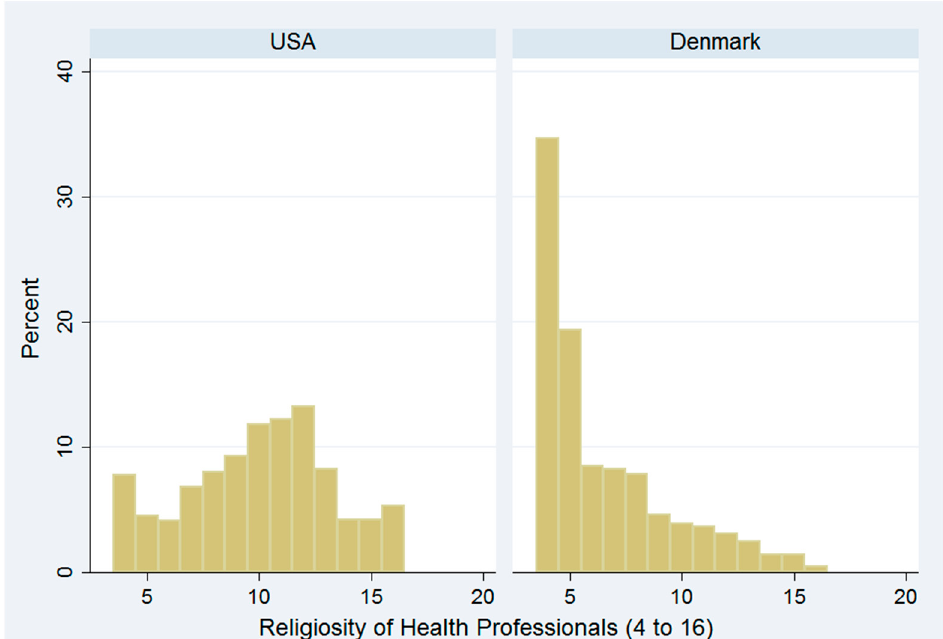
Figure 1. Bar chart illustrating the distribution of American and Danish physicians’ religiosity. Level of religiosity is measured employing a factor composed of four items. The scale ranges from 4–16, with 4 being the least religious and 16 being the most religious.